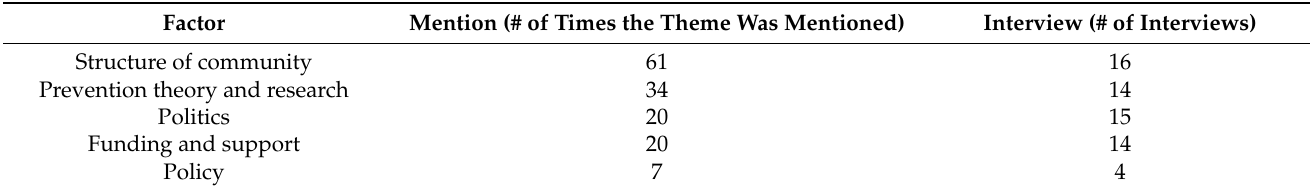
Table 1. Community-level factors that affected Healthy Kids Community Challenge (HKCC) implementation, reported by interview